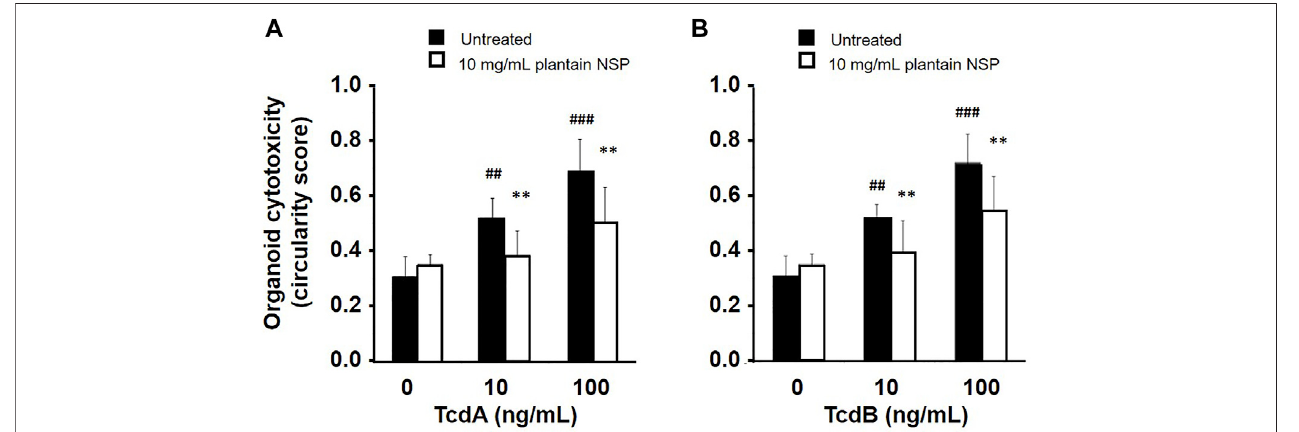
FIGURE6| SolubleNSP from plantaininhibits C.dif fi cile toxin-induced cytotoxicityinintestinal cryptstemcell-derived organoids. Intestinal organoid cultures were pre-treatedfor30 minwith10 mg/mlplantainNSPbeforetreatmentwith10and100 ng/mlof C.dif fi cile toxins, (A) TcdAor (B) TcdB.PlantainNSPsigni fi cantlyreduced TcdA-andTcdB-inducedcytotoxicity(asassessedbyrounding/circularityscore)comparedtovehicle(sterilePBS,pH7.3)pre-treatedcontrols.Organoidroundingwas quanti fi ed as previously described (Parsons et al., 2015), with circularity values possible between 0 and 1, and where a score of 1 indicates a perfect circle. Data expressed asmean ± SD( N (cid:2) 4). Signi fi cantdifferencesoftoxin-induced response tountreated controls, ## p < 0.01, ### p < 0.001,and plantainNSP versusvehicle pre- treated controls; ** p < 0.01; One-way ANOVA, with Dunnett ’ s post-hoc